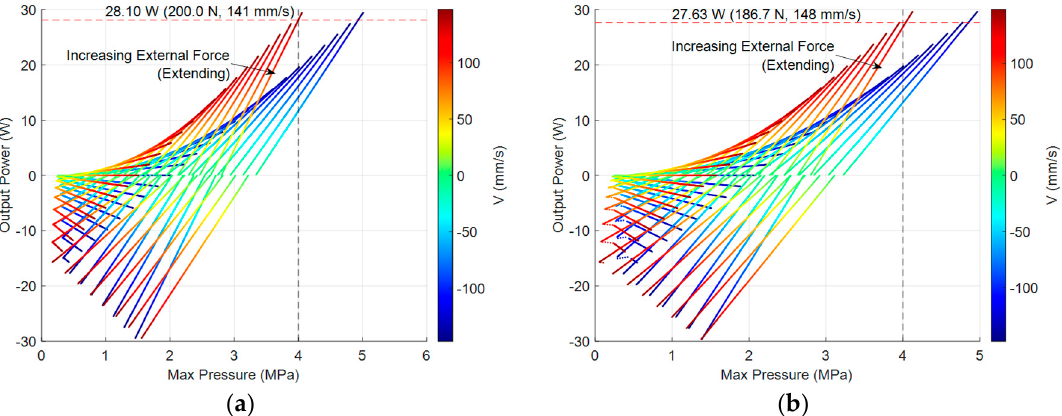
Figure 10. Calculated steady state model output power ( F ext V ) for external forces varying from − 200 N to 200 N, with maximum power identified (limited by 4 MPa pressure limit). ( a ) Valve A (steel sleeve and spool); ( b ) Valve B (entirely 3D printed).